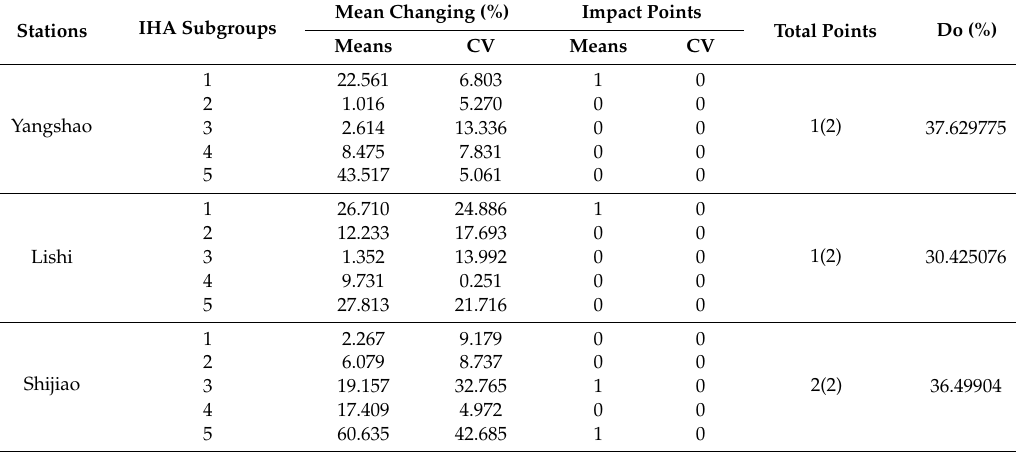
Table 5. The Dundee Hydrological Regime Alteration Method and Do of three stations and hydrological alteration indicators of three stations.